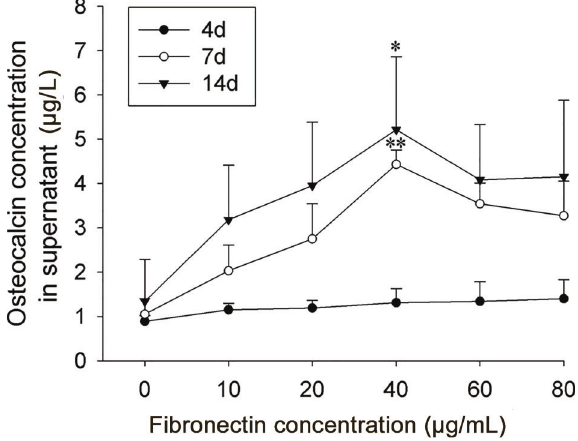
Figure 9. Osteocalcin concentration increased with culture time in all groups. The 40 m g/mL fi bronectin was statistically signi fi cant at 7 (**P o 0.01) and 14 days (*P o 0.05) compared to the other groups (ANOVA). Data are reported as means ±